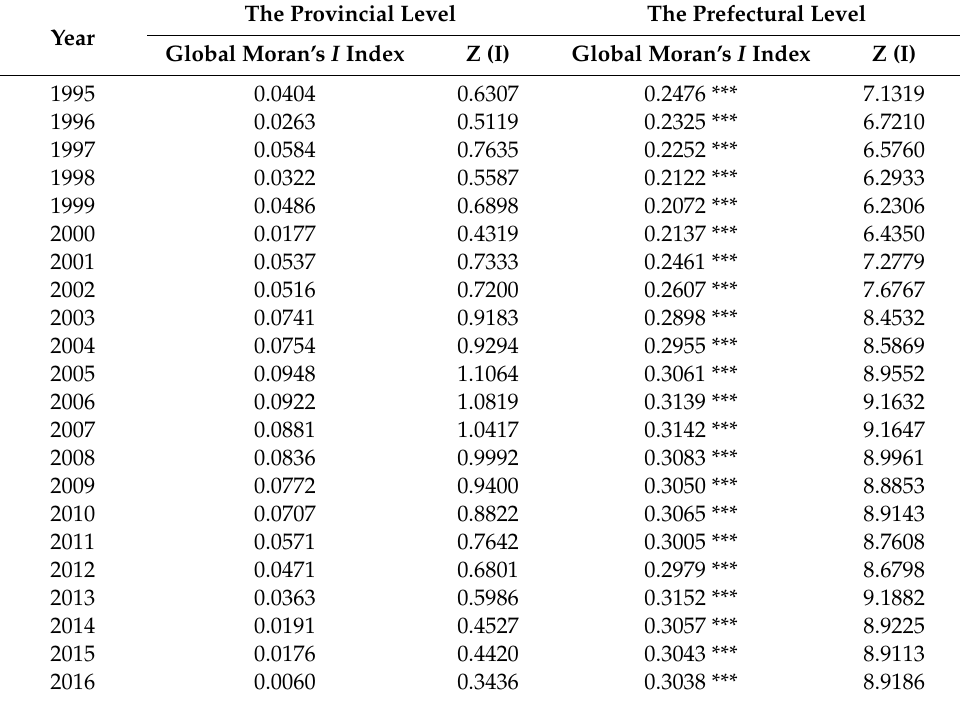
Table 5. Global Moran’s I index of China’s energy consumption in